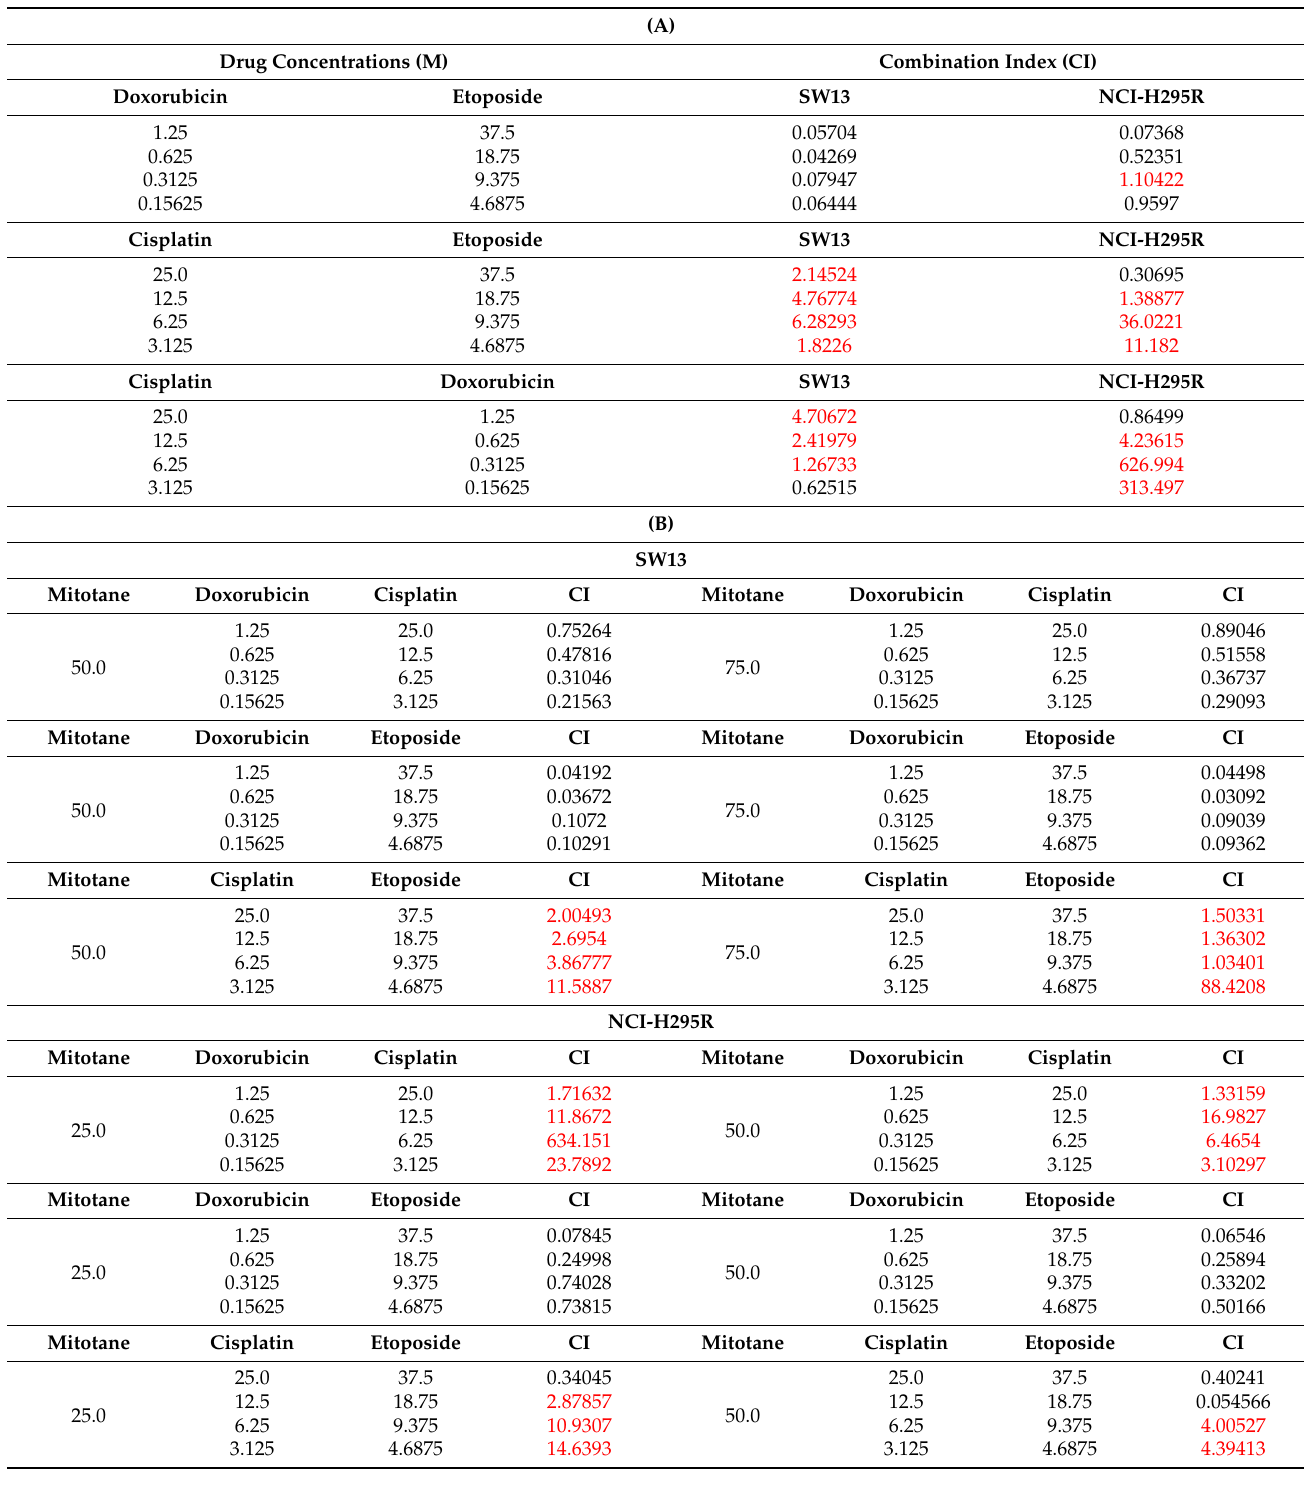
Table 2. ( A , B ) ACC cell lines NCI-H295R (Left) and SW13 (Right) were treated with varying concentrations of combinations of chemotherapeutics without (( A )-Top) or with (( B )-Bottom) mitotane for 72 h and the combination Index was calculated using Chou-Talalay equation. C < 1 is synergistic, C = 1 additive, and C > 1 is antagonistic (Red text).